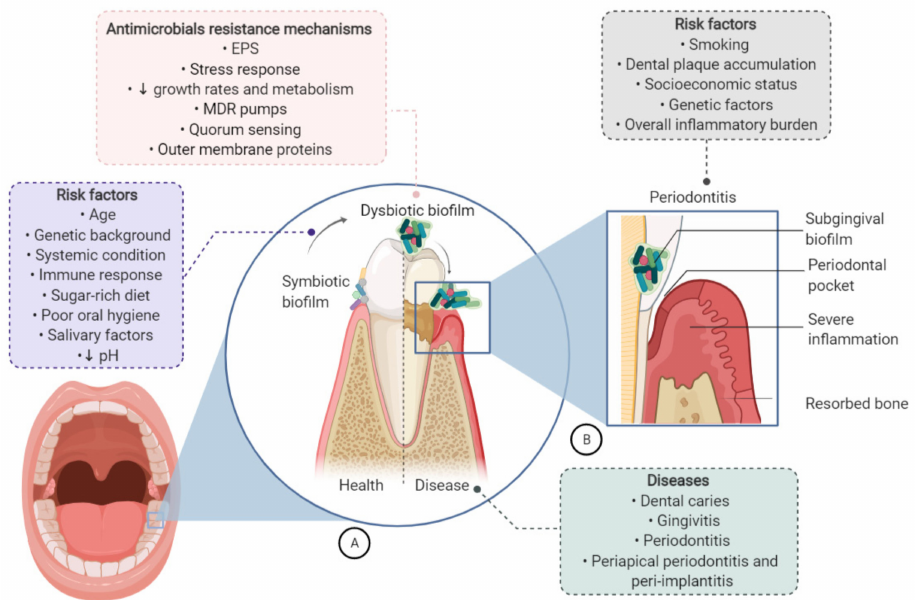
Figure 2. Dysbiosis as a trigger of oral diseases. ( A ) Development of oral biofilm from health to disease conditions, the associated risk factors, and the antimicrobial resistance mechanisms. ( B ) Development of periodontitis and related risk factors. (Created with BioRender.com accessed on 27 April